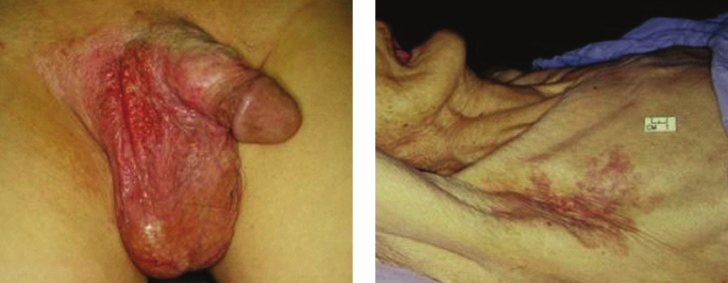
Figure 1: (Left) EMPD of the penoscrotal region. (Right) EMPD of the axilla. The disease usually presents as erythematous, “weepy” lesion, which often mimics benign inflammatory dermatological conditions, such as eczema.